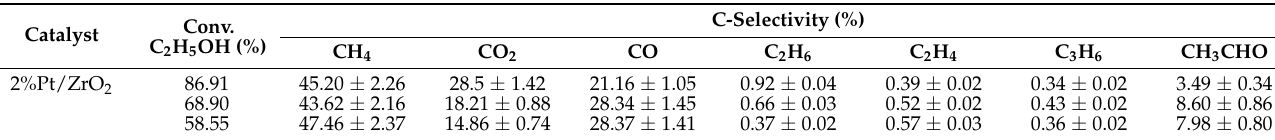
Table 5. ESR activity for 2%Pt/ZrO 2 at different C 2 H 5 OH conversion (300 ◦ C, 1 atm, feed: C 2 H 5 OH 2.98%/H 2 O 26.14%/N 2